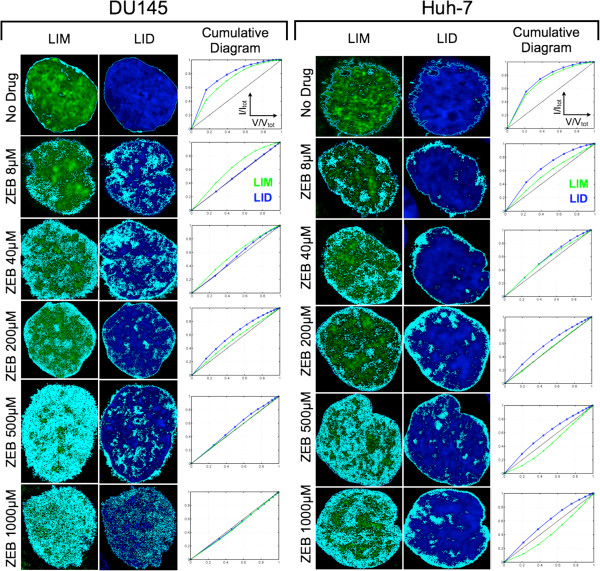
Differential LIM and LID topology in zebularine-treated cells. LIM and LID sites detected in the range of (tbcg, tQ) in individual cells from Figure
6 (marked in cyan color) are superimposed onto an intermediate optical section in the respective MeC (green) and DAPI (blue) channels (left and middle columns). LIM/LID density curves obtained through morphological erosion of nuclei are shown as cumulative diagrams (right column). These sites correspond with codistribution patterns in Figure
4 for the respective nuclei. The number of graph points in the third column is associated with the number of detected shells; the value of each point refers to the fraction of all sites found in the nucleus up to the next shell. V is the shell volume and Vtot is the total volume of a nucleus. The argument V/Vtot = 0.5 distinguishes all LIM sites that are localized in the peripheral half of the nucleus from LIMs of the interior half (V/Vtot > 0.5). The diagonal line across each plot in represents hypothetically equal density of LIM or LID sites across the nuclear volume. Similar degrees of high rim-like LIM and LID densities are apparent in untreated prostate and hepatic cancer cell nuclei. LIM sites quasi-linearly expand towards the nuclear interior upon the increase of zebularine concentration, with ZEB at 500–1000 μM show large coverage in Huh-7 nuclei and nearly full coverage throughout DU145 nuclei. Also LIDs show an increased distribution in treated cells versus naïve cells, but the changes are more similar across all the applied ZEB and AZA concentrations in both cell types, with most increases occurring in the exterior shells of the nuclei.